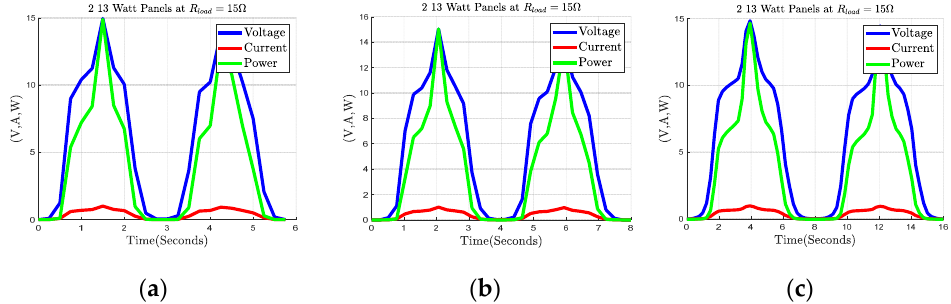
Figure 14. Output voltage, current, and power measured while simulated vehicle in motion using the 2 of 13 W SunKingdom ® solar panels and under different speeds (1.12 m/s ( a ), 2.24 m/s ( b ), and 3 m/s ( c ), from left to right, respectively).